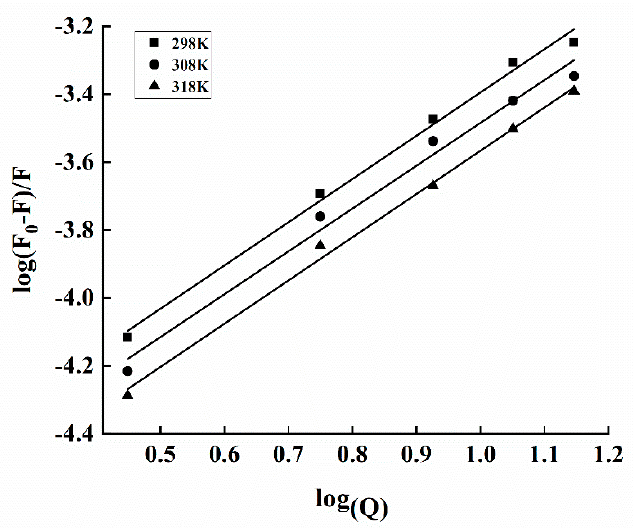
Figure 7. Plots of log[(F0 − F)/F] vs. log(Q) for the interaction between Mal − mPEG5000 and SPA at different temperatures.